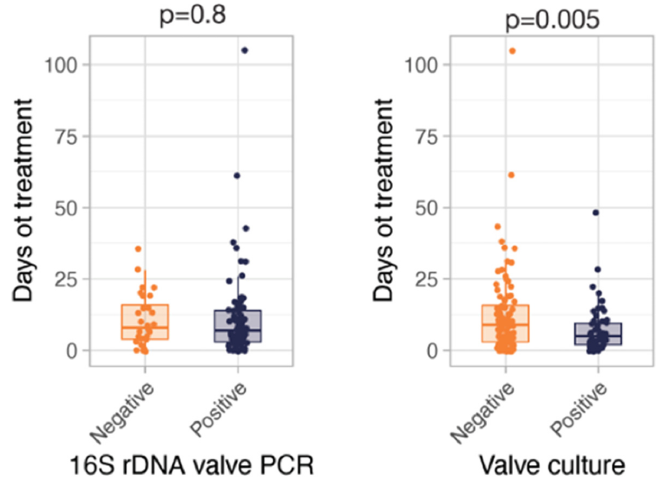
Figure 1. Antimicrobial therapy duration before surgery and its relatedness with valve culture and 16S rDNA PCR results. Bars represent the median of days.